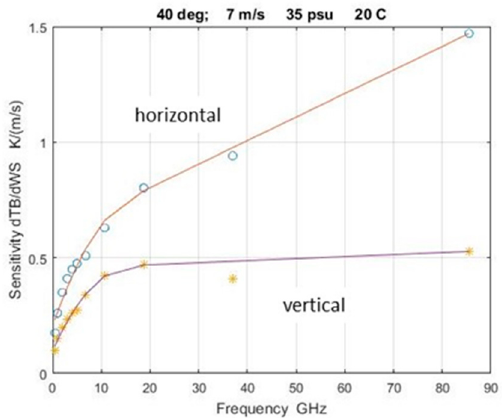
Figure 12. Sensitivity of brightness temperature to wind speed, dTB/dWS, as a function of frequency: Incidence angle = 40 ° ; WS = 7 m/s; SST = 20 ℃ ; SSS = 35 psu.